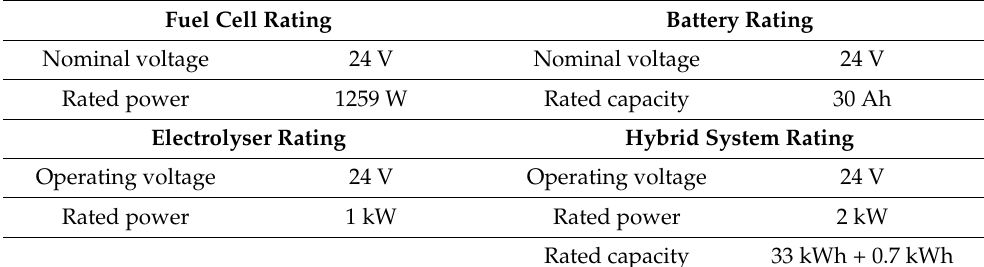
Figure 16. Output comparison graph.